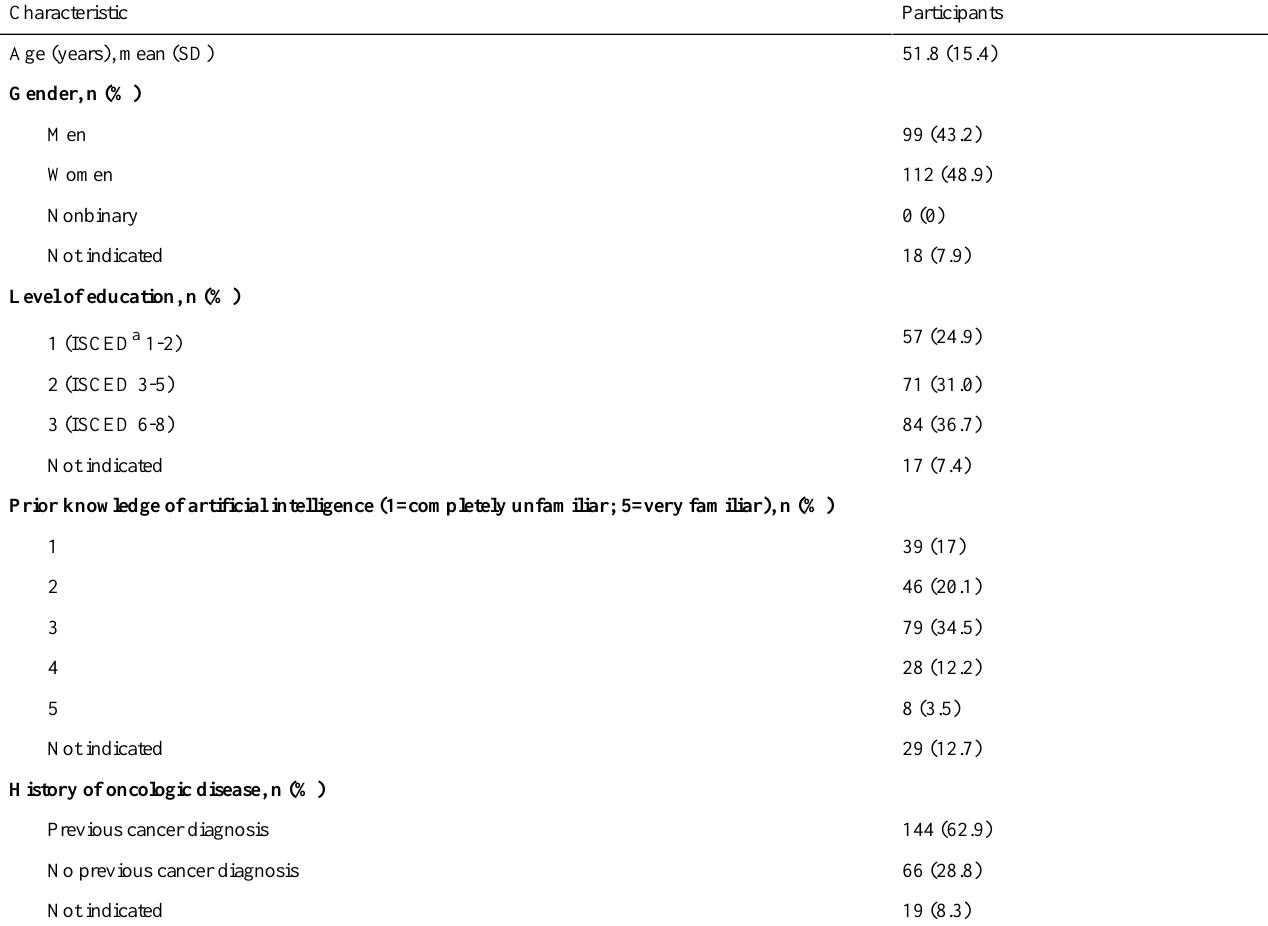
Table 1. Data obtained from the questionnaire participants (N=229).